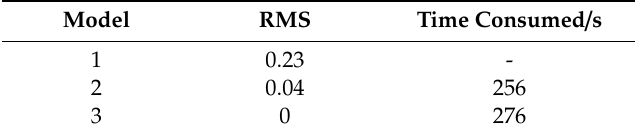
Table 4. RMS prediction errors of the three models in the 1 KHz frequency band.